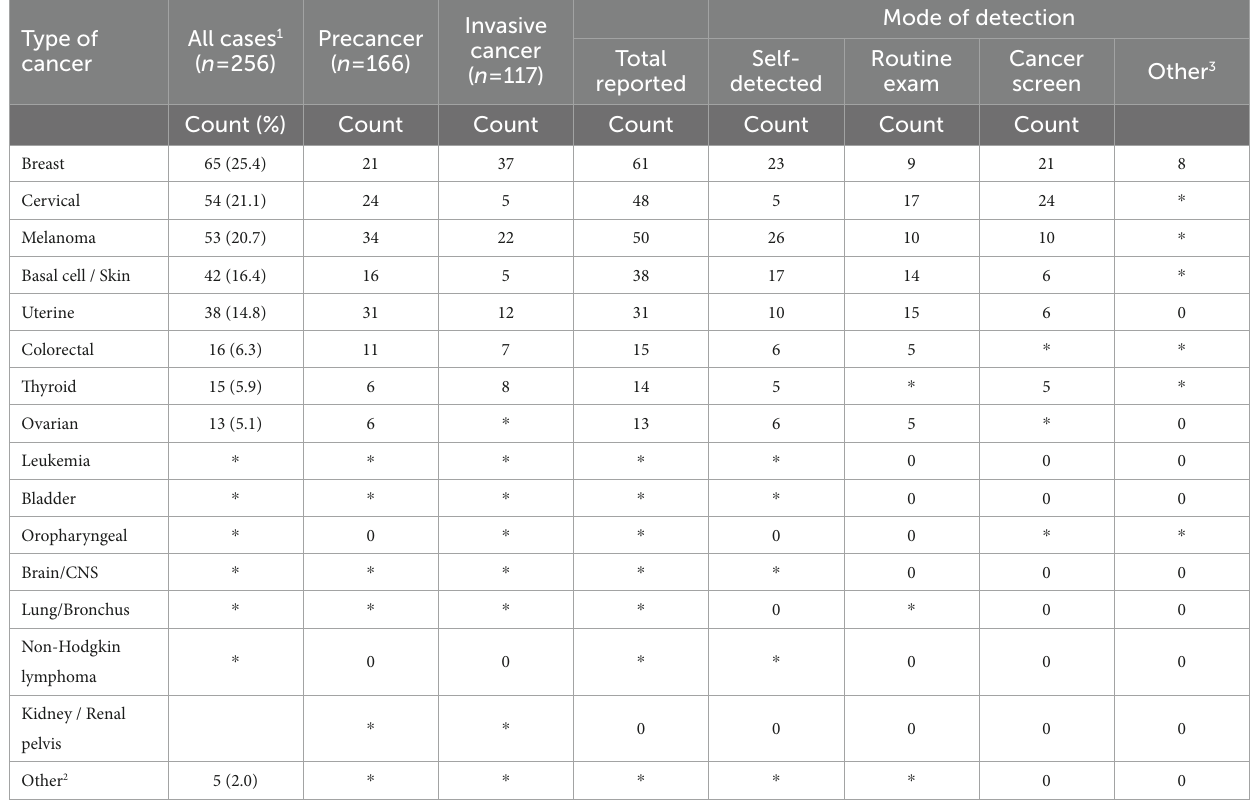
TABLE 4 Cancers experienced by female firefighter survey respondents, by precancer or cancer diagnosis, and by mode of detection.